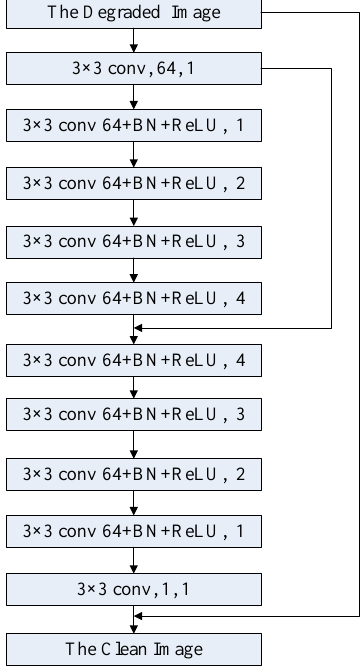
Figure 1. The architecture of proposed network FbResNet.